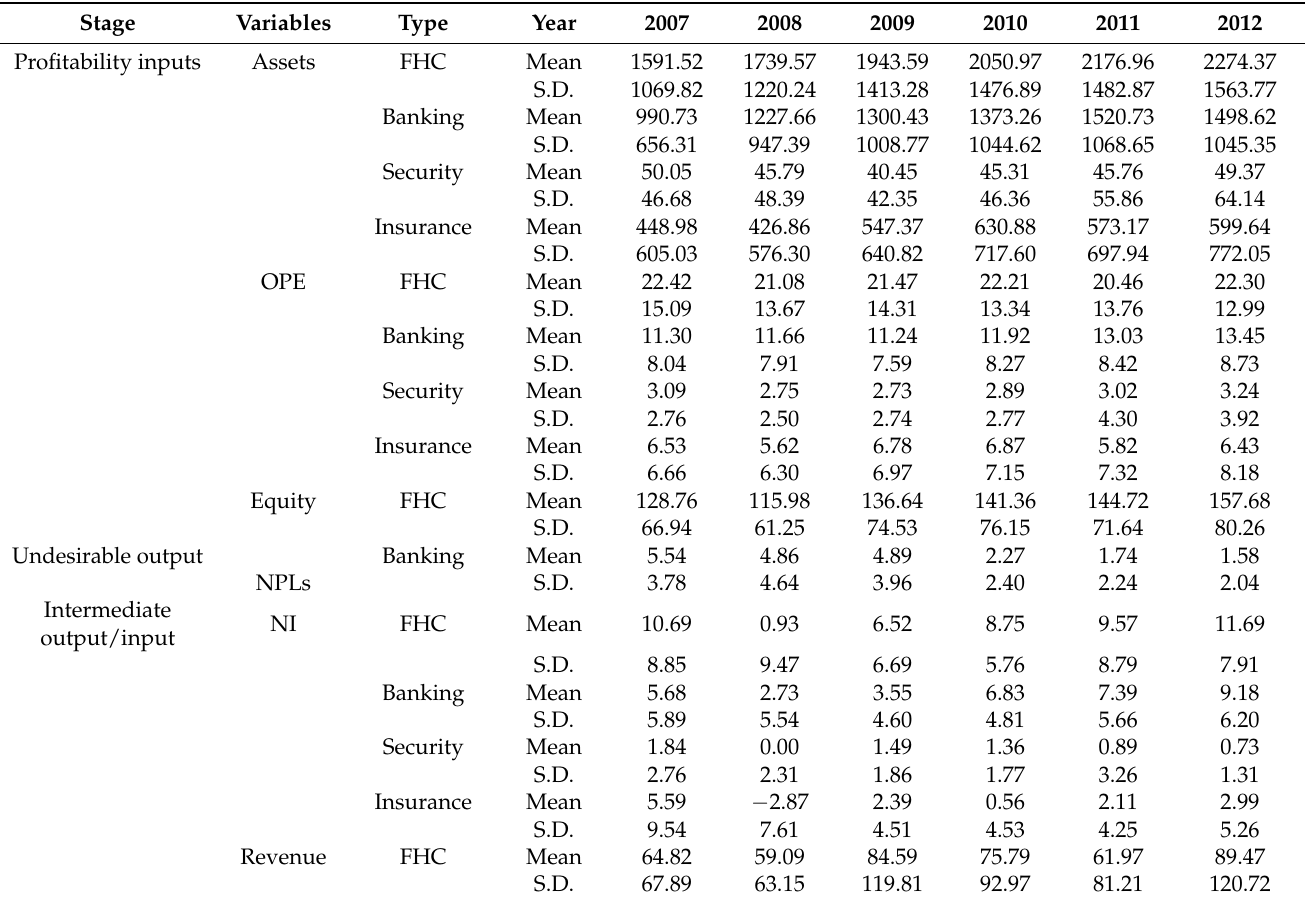
Table 2. Descriptive statistics of all possible variables for the period